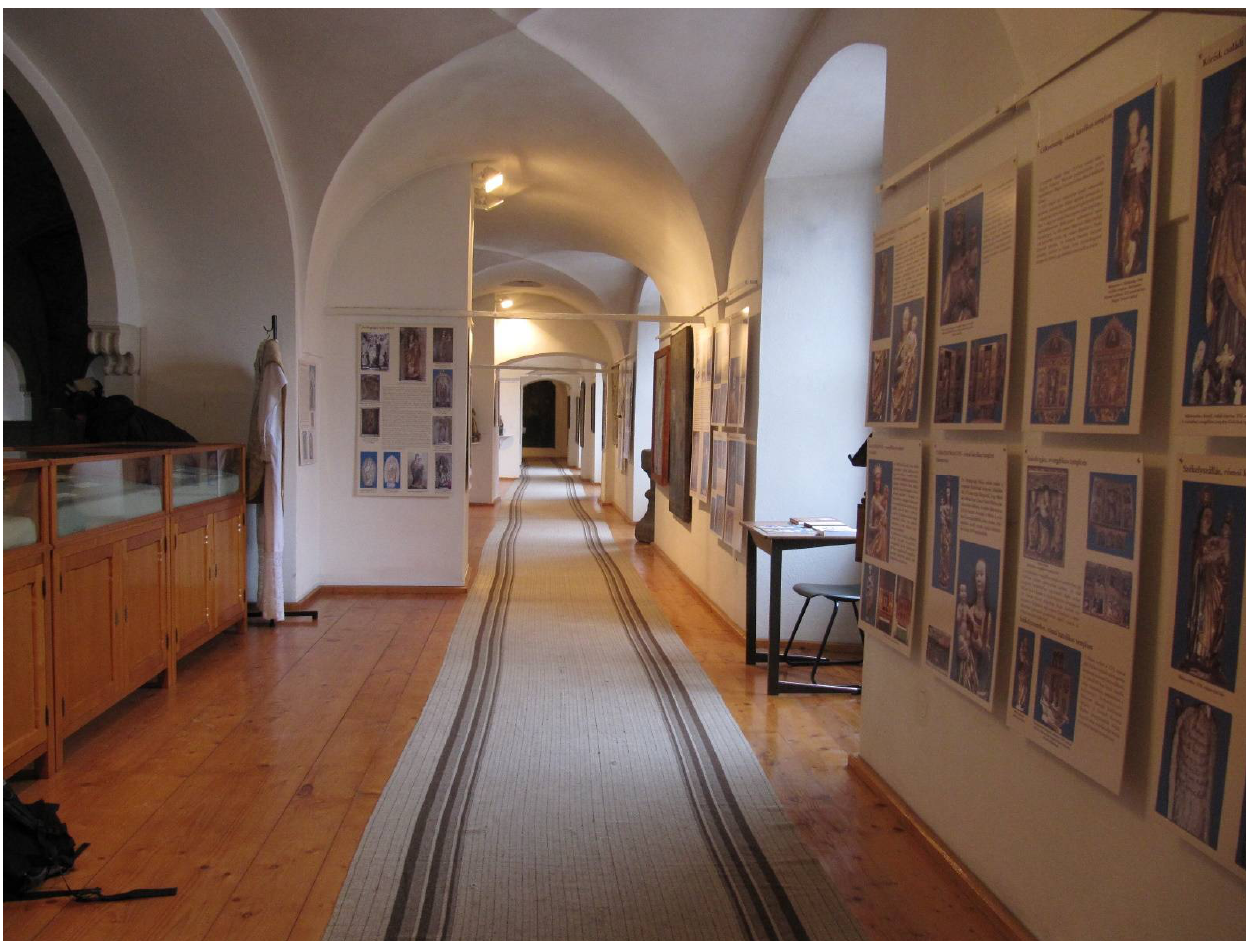
Figure 4. Târgu Mureș Exhibition Space. Figure 4. T â rgu Mures